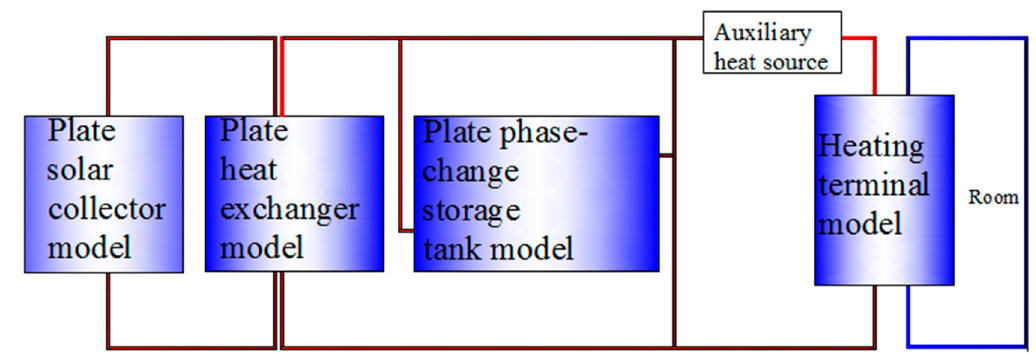
Figure 3. Simplified dynamic simulation model of SHS-PCM.